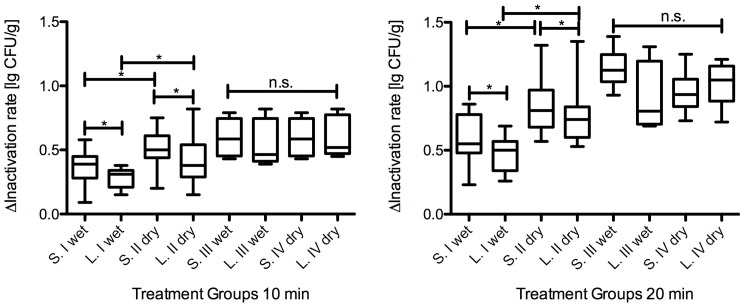
Inactivation of S. Typhimurium and L. monocytogenes after 10 and 20 min plasma treatment using four different plasma-modes.This figure shows inactivation of S. Typhimurium and L. monocytogenes after 10 min and 20 min CAP-treatment. Numbers I-IV are the four different trial groups. Represented significances are for groups I and II, and for groups III and IV, respectively. Results represent the mean ± standard error, p is defined as p > 0.05 *, no significant difference as n.s.